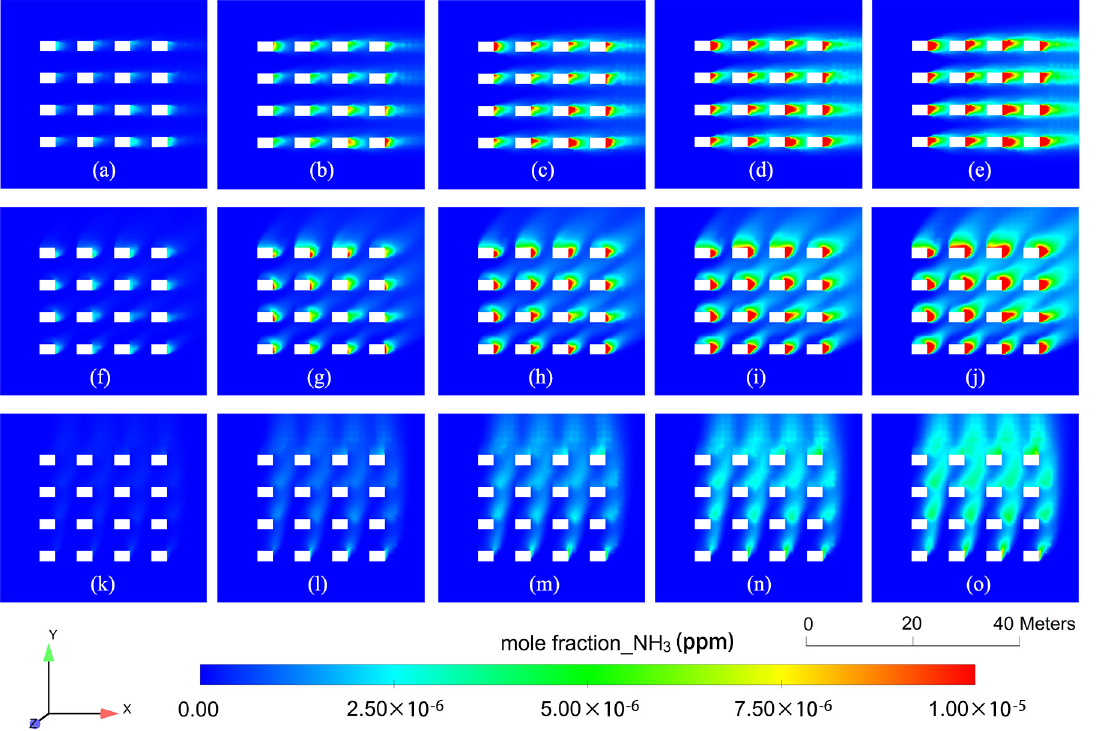
Figure 6. Ammonia mole fraction at 1.5 m above the ground in scenarios with 4 m intervals, in which the wind direction and outlet emission intensity are: ( a ) 0° and 10 ppm; ( b ) 0° and 30 ppm; ( c ) 0° and 50 ppm; ( d ) 0° and 70 ppm; ( e ) 0° and 90 ppm; ( f ) 45° and 10 ppm; ( g ) 45° and 30 ppm; ( h ) 45° and 50 ppm; ( i ) 45° and 70 ppm; ( j ) 45° and 90 ppm; ( k ) 90° and 10 ppm; ( l ) 90° and 30 ppm; ( m ) 90° and 50 ppm; ( n ) 90° and 70 ppm; ( o ) 90° and 90 ppm.